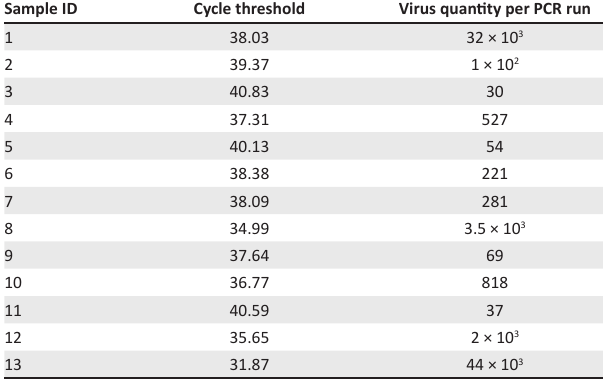
TABLE 1: Thermal cycle and virus load for Human Herpes Virus type-6 positive individual cerebrospinal fluid specimens using quantitative TaqMan real-time polymerase chain reaction, Khartoum, Sudan, December 2009 – August 2010. Sample ID